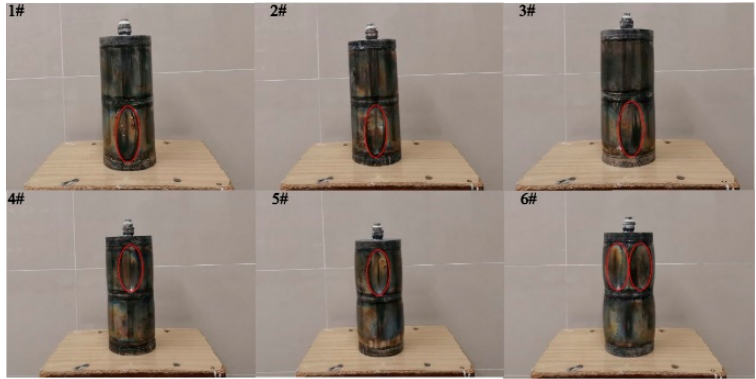
Figure 10. Bi-segment collapsed cylindrical preform (preform 1) and bulged hulls (hulls 2–6) after the hydrostatic tests.